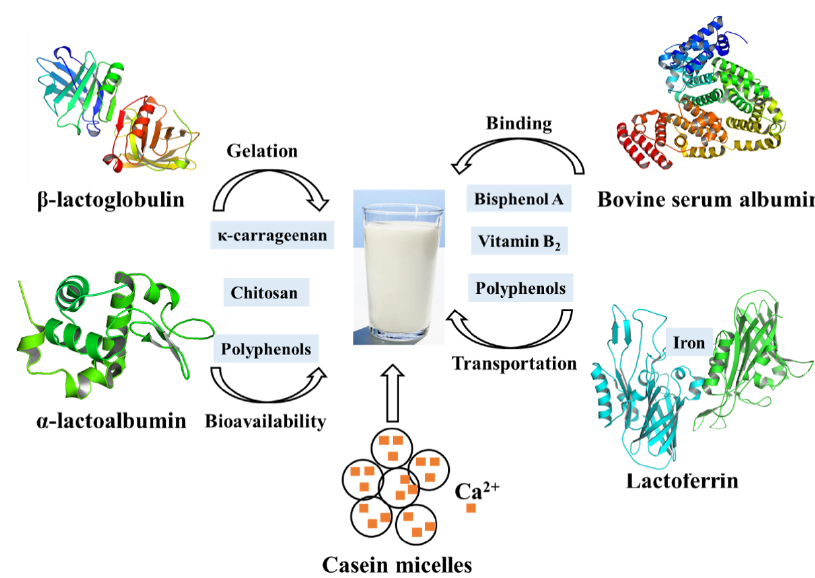
Figure 3. Main proteins in milk and their contributions to the quality of dairy